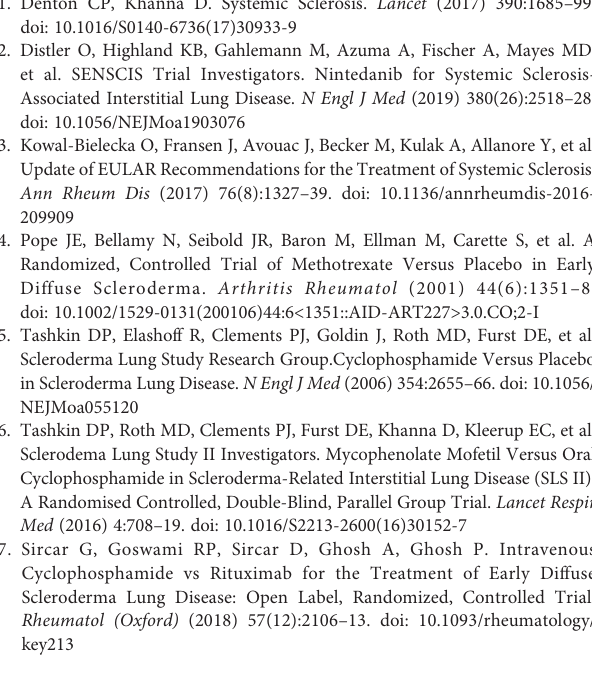
Supplementary Figure 1 | Course of skin and lung parameters of 7 SSc patients, who did not receive immunosuppression after aHSCT. The mRSS did not change after aHSCT (12.0 [12.0-40.0]monthsafter aHSCT the median mRSS was 6.0[4.0- 17.0]; 28.0 [23.0-119.0] months after aHSCT the mRSS was 7.0 [4.0-14.0], P = 0.450). The median FVC and DLCO (each in percentage of predicted) did not show signi fi cant differences 14.0 (12.0-40.0) months after aHSCT compared to 29.0 (23.0-119.0) months after aHSCT (FVC: 65.0 [52.0-87.0] % vs 76.0 [66.0-87.0] %, P = 0.674; DLCO: 30.0 [27.0-51.0] % vs 34.0 [23.0-48.0] %, P = 0.865). The individual data is shown for (A) mRSS, (B) FVC, and (C) DLCO. The cohort of SSc patients after aHSCT, who did not receive IS, comprised 11 patients, but retrospective data was not available from 4 patients due to short follow up or because of fatal complications in the course of disease. Supplementary Figure 2 | Improvements of non-skin and non-lung parameters in SSc patients with former aHSCT after rituximab (RTX) application. (A) Course of urine parameters and of MPO-ANCAs of one SSc patient, who had developed a microscopic polyangiitis after aHSCT and therefore received RTX. (B) Course of thrombocytes of one SSc patient, who developed immune thrombocytemia and therefore received RTX. (C) Course of creatine kinase (CK) of a SSc patient, who developed myositis after aHSCT and therefore received RTX; mo, months; MPO- ANCA, myeloperoxidase anti-neutrophilic cytoplasmic